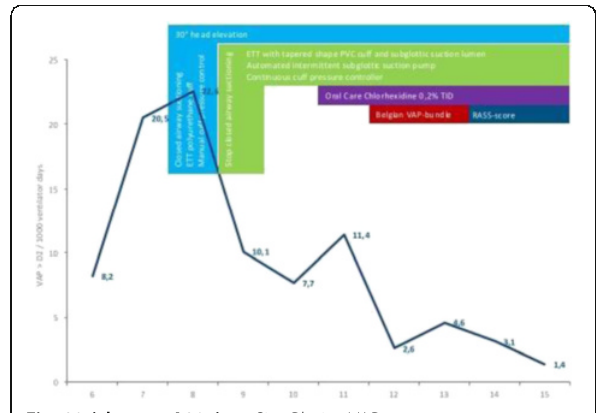
Fig. 89 (abstract A204). az Sint-Blasius